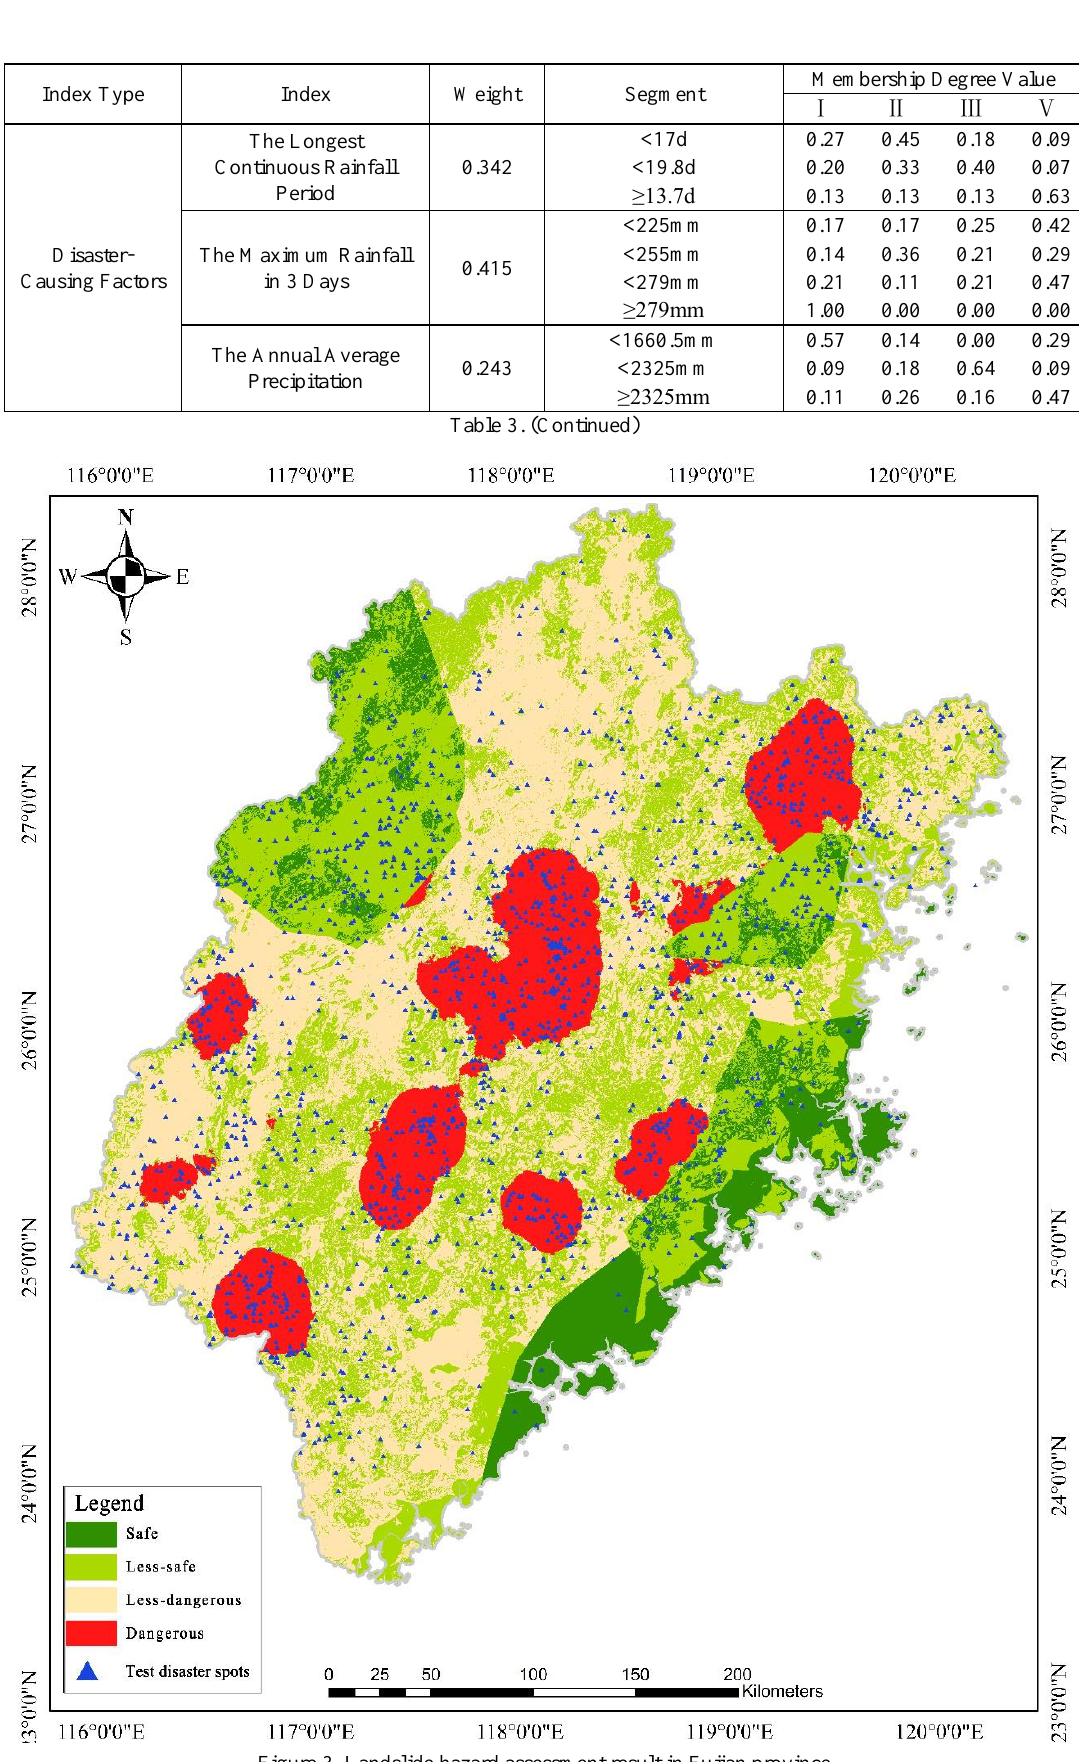
Figure 3. Landslide hazard assessment result in Fujian